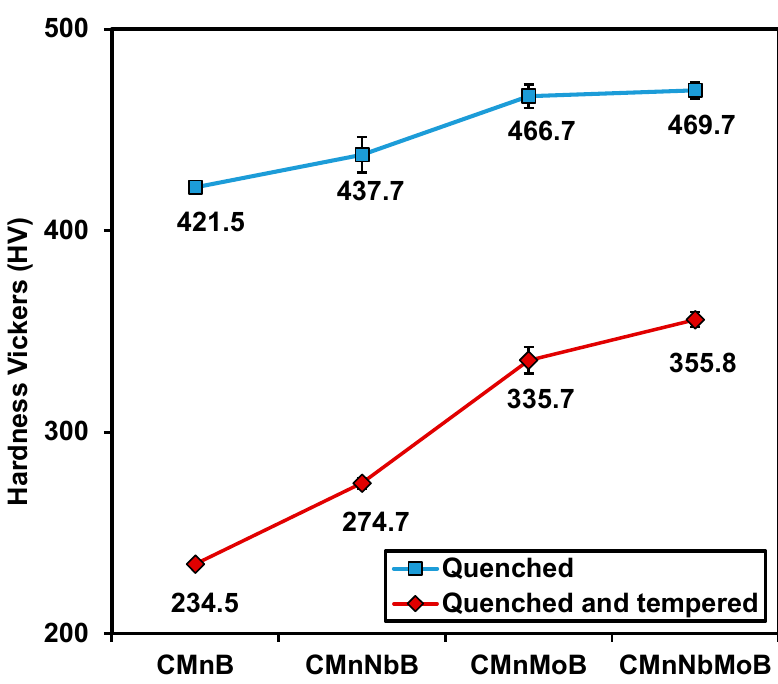
Figure 9. Hardness measurements for all steel grades for Q and Q + T cycles.